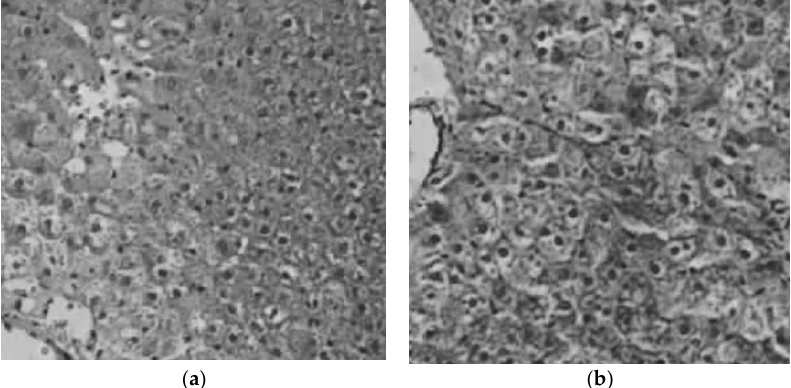
Figure 4. Hepatic biopsies images: ( a ) untreated animal from de control group; and ( b ) animal treated with NHs.